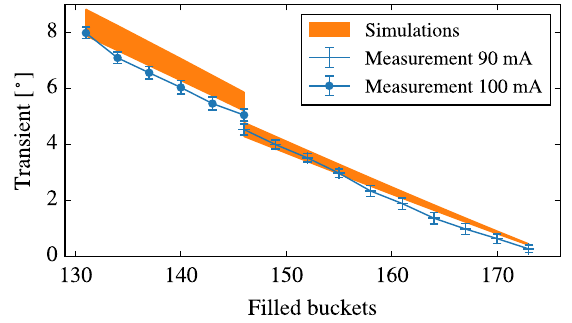
FIG. 10. Measured and simulated transient as function of number of filled bucket for two different measurement series with 100 mA and 90 mA average current, respectively. The simulation results are plotted for a main cavity range between 988.3 kV (upper limit) and 1026 kV (lower limit). The error bars on the measurement corresponds to the error in the fit of the phase calibration as well as error in the fit of the transient.